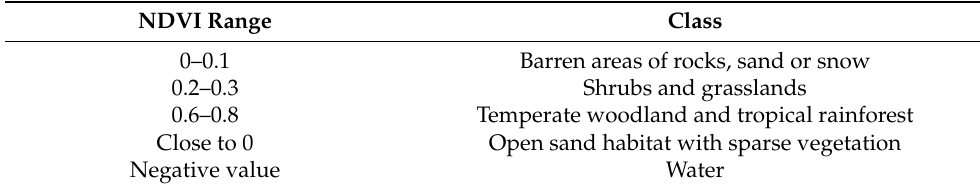
Table 3. NDVI values according to